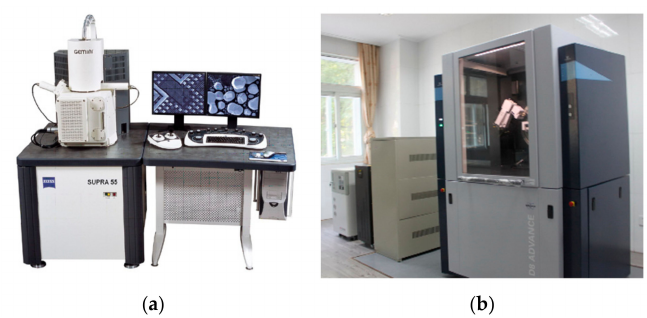
Figure 4. The test instruments: ( a ) the Zeiss Supra 55 field emission scanning electron microscope; ( b ) the D8-Advance type crystal X-ray di ff ractometer.